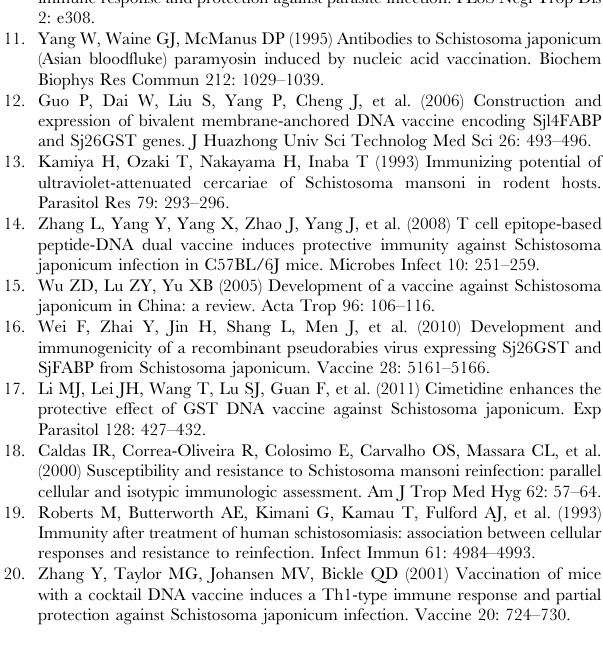
Figure S1 Levels of cytokine production in vivo. Two weeks after the last immunization, serum was isolated and assayed for IL-2, IL-10, IL-4, and IFN- c production. Data from 3 experiments are expressed as the mean 6 SD. Statistically significant differences (P , 0.01) are indicated by **compared with the membrane-anchored group. (TIF) Figure S2 Percentages of CD4 + and CD8 + cells among the CD3 + cells detected by flow cytometry. A: The ratio of CD3 + CD4 + /CD3 + and CD3 + CD8 + /CD3 + . There was no statis- tically significant difference in the percentages of CD4 + and CD8 + T cells among the CD3 + cells between the experimental and control groups. B: Numbers of CD3 + cells among the total splenocytes. Flow cytometry showed that the number of CD3 + cells among the total splenocytes increased significantly in the vaccinated groups. Values represent means 6 SD. N= 10 per group. *P , 0.05, versus the control group; # P , 0.05, versus the membrane-anchored pIRES-sjFABP-sj26GST group.